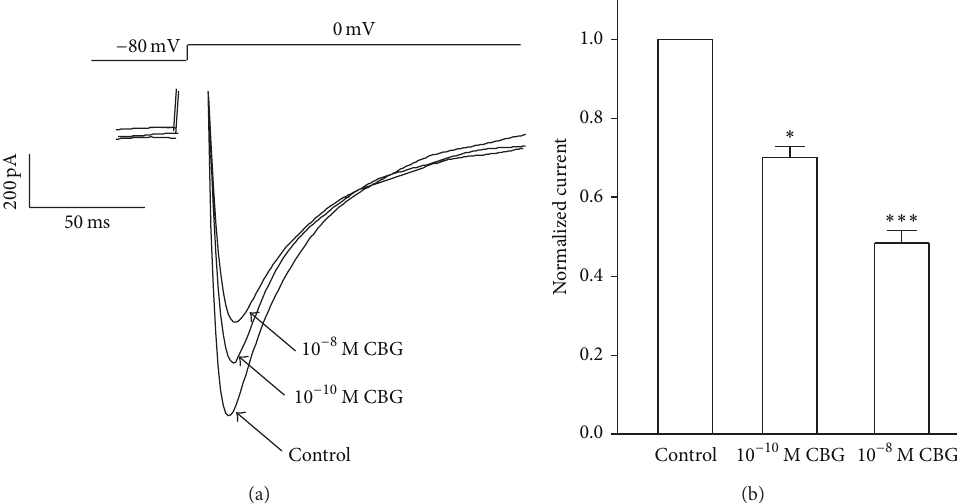
Figure 5: Effects of CBG on 𝐼 of ventricular myocytes from rat hearts with myocardial ischemia. 𝐼 Ca-L conditions, during exposure to 10 −10 and 10 −8 M CBG. Data are means ± S.E.M. ( 𝑛 = 5 cells). ∗ 𝑃 < 0.05 , ∗∗∗ 𝑃 < 0.001 , versus control.